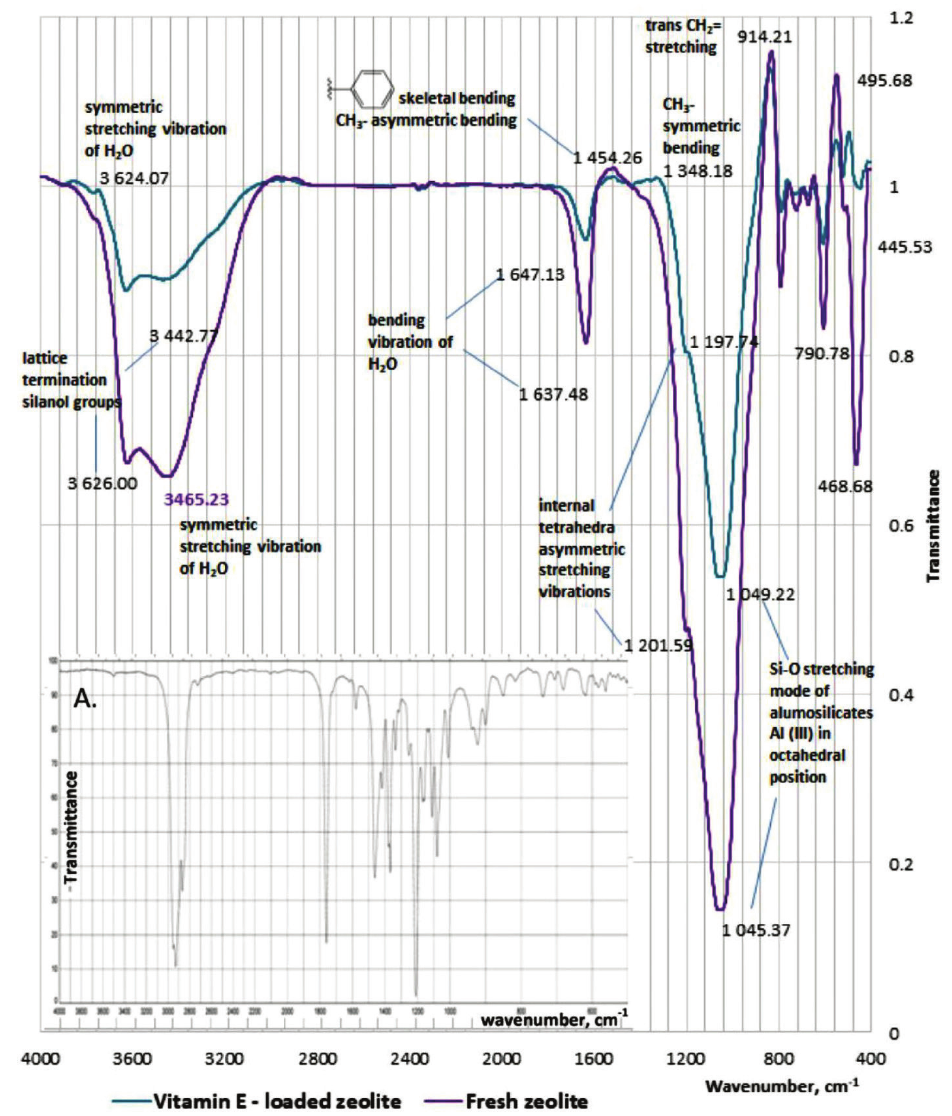
Fig. 2 – FTIR spectra of fresh zeolite, vitamin E-loaded zeolite, and pure d , l -α-tocopherol (adapted from 23